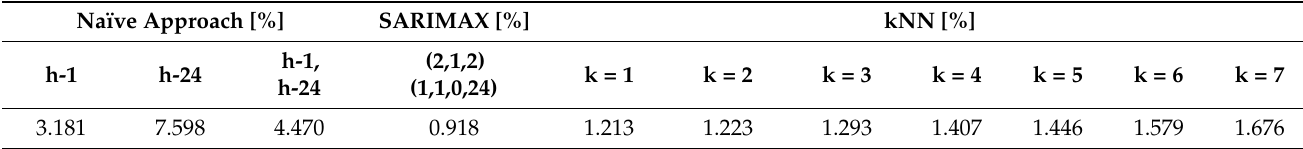
Table 2. MAPE values for Pareto fronts and ‘no data selection’ models for the first verification case. Pareto Fronts [%] No Data Selection [%] 1